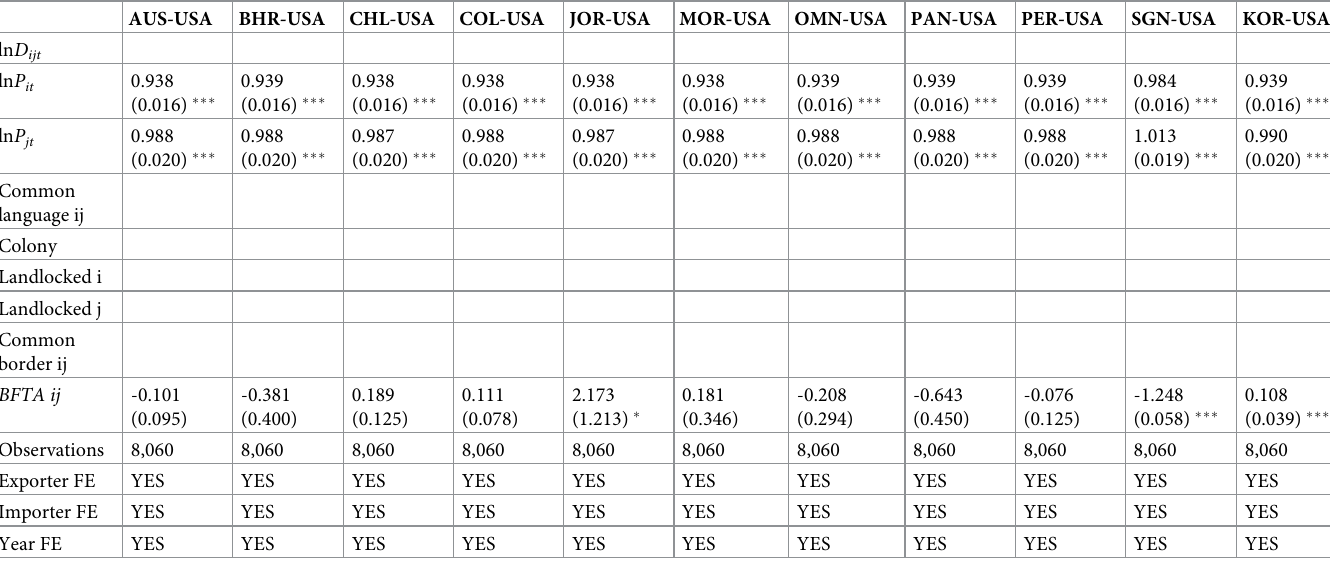
Table 9. PPML estimation results with country and time fixed effects for the United States as an